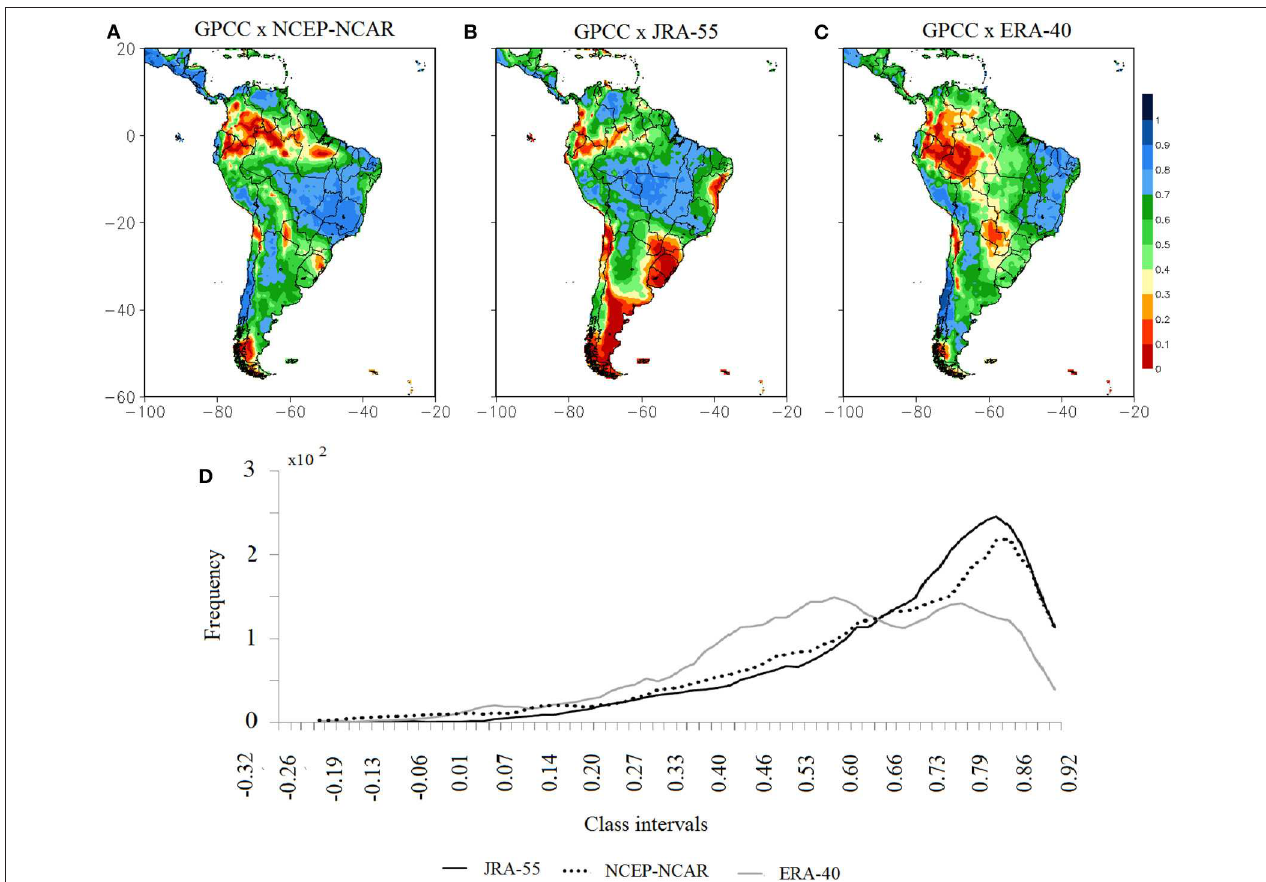
FIGURE 10 | Linear correlation coefficient between monthly GPCC and (A) NCEP-NCAR reanalysis I, (B) JRA-55, and (C) ERA-40, from 1970 to 2001, for the tropical South America area (25 ◦ S − 10 ◦ N). (D) Linear correlation coefficient frequency distribution for each map in (A–C) . The data used in the correlation computation presents original